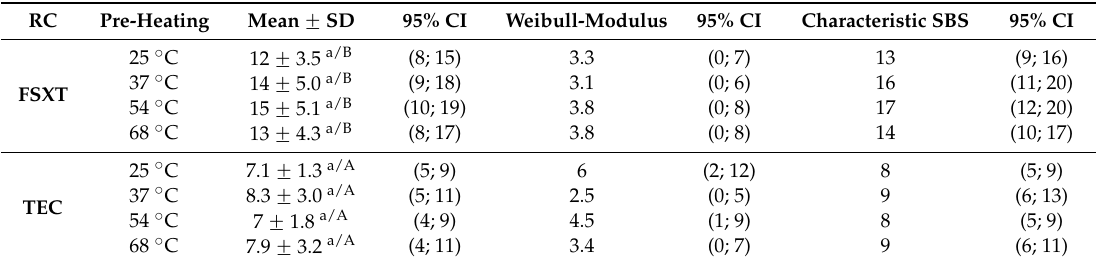
Table 3. Mean with standard deviation for shear bond strength (SBS) to dentin (MPa) appendant Weibull modulus and characteristic SBS as well as 95% confidence interval (CI) for each tested RC by each pre-heating temperature.